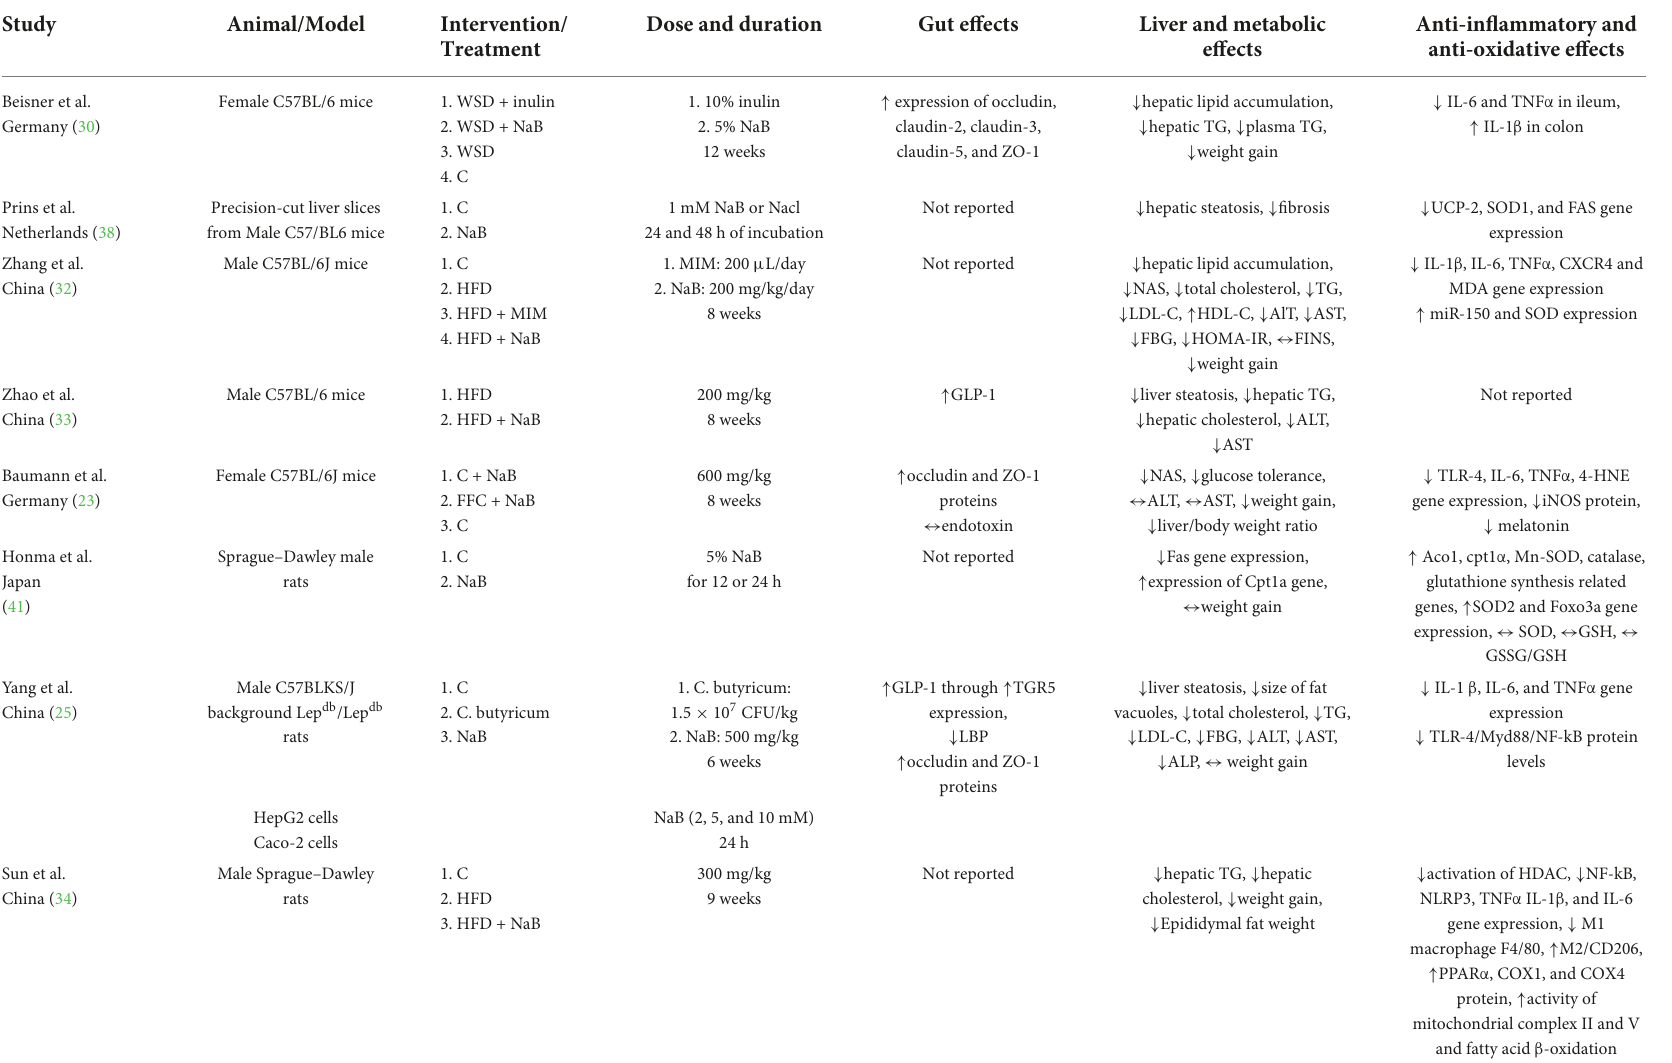
TABLE 1 Summary of the studies about the effects of NaB on NAFLD and associated risk